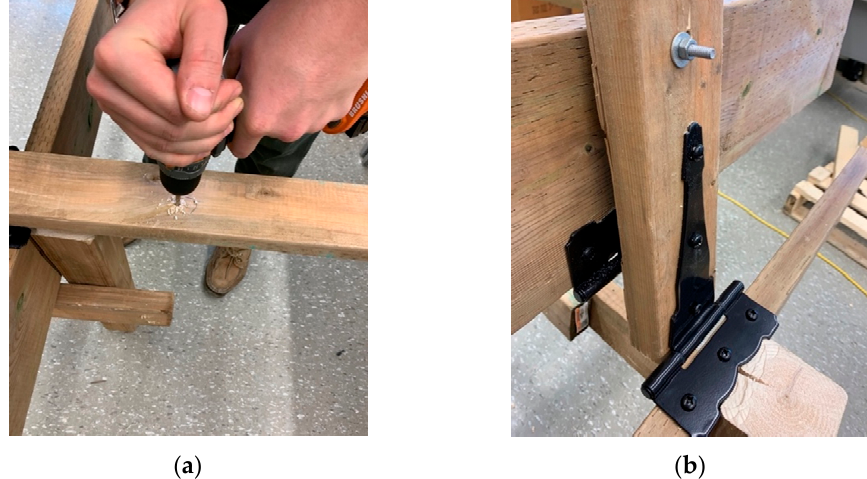
Figure 6. ( a ) 1/4 ″ holes drilled based on preferred tilt angle, and ( b ) the 2 × 4 connected to the frame via a nut, bolt, and washer. via a nut, bolt, and washer.